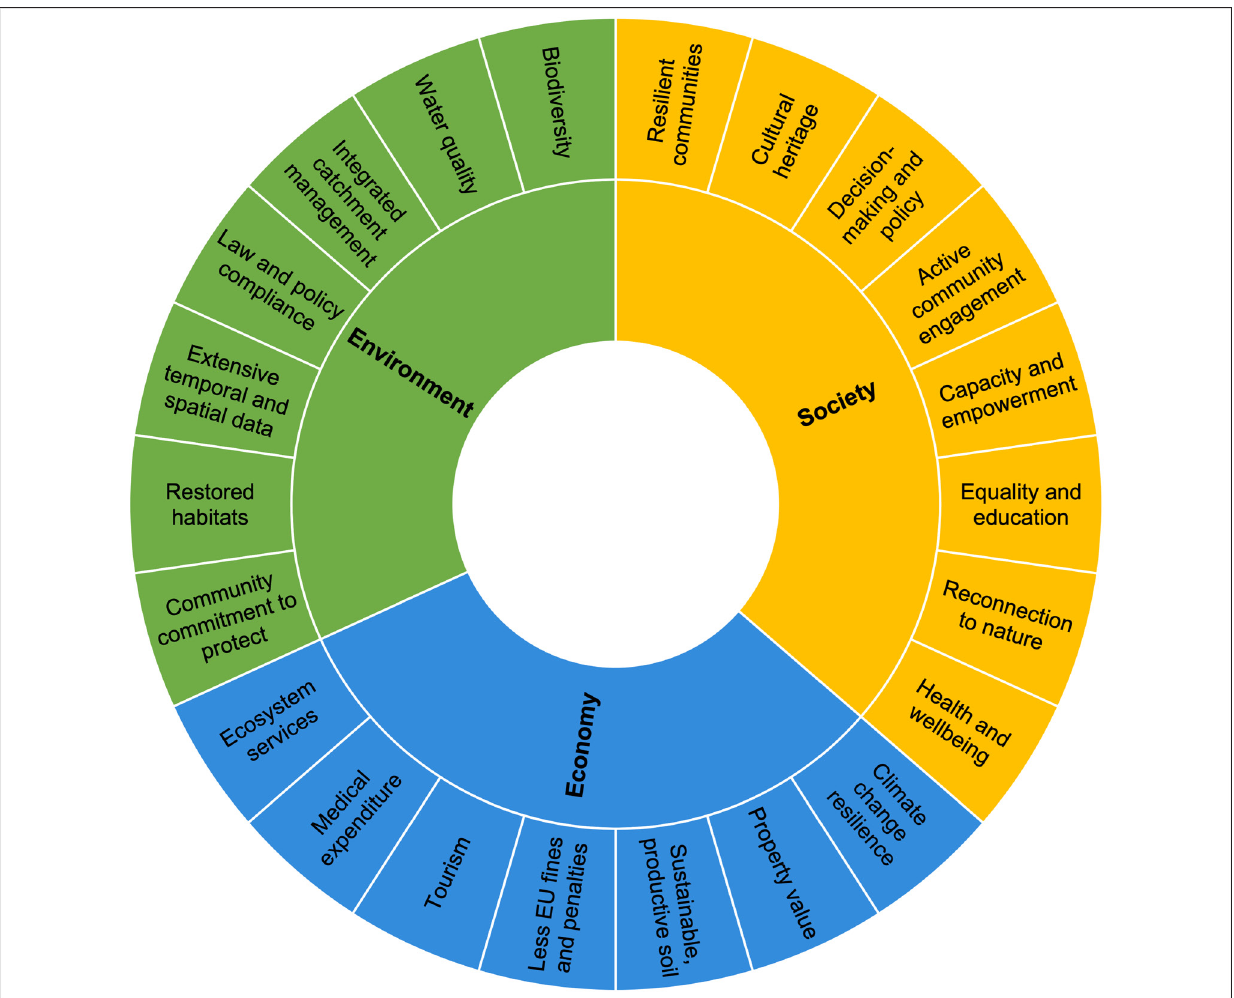
Figure 4 Benefits of nature-based citizen